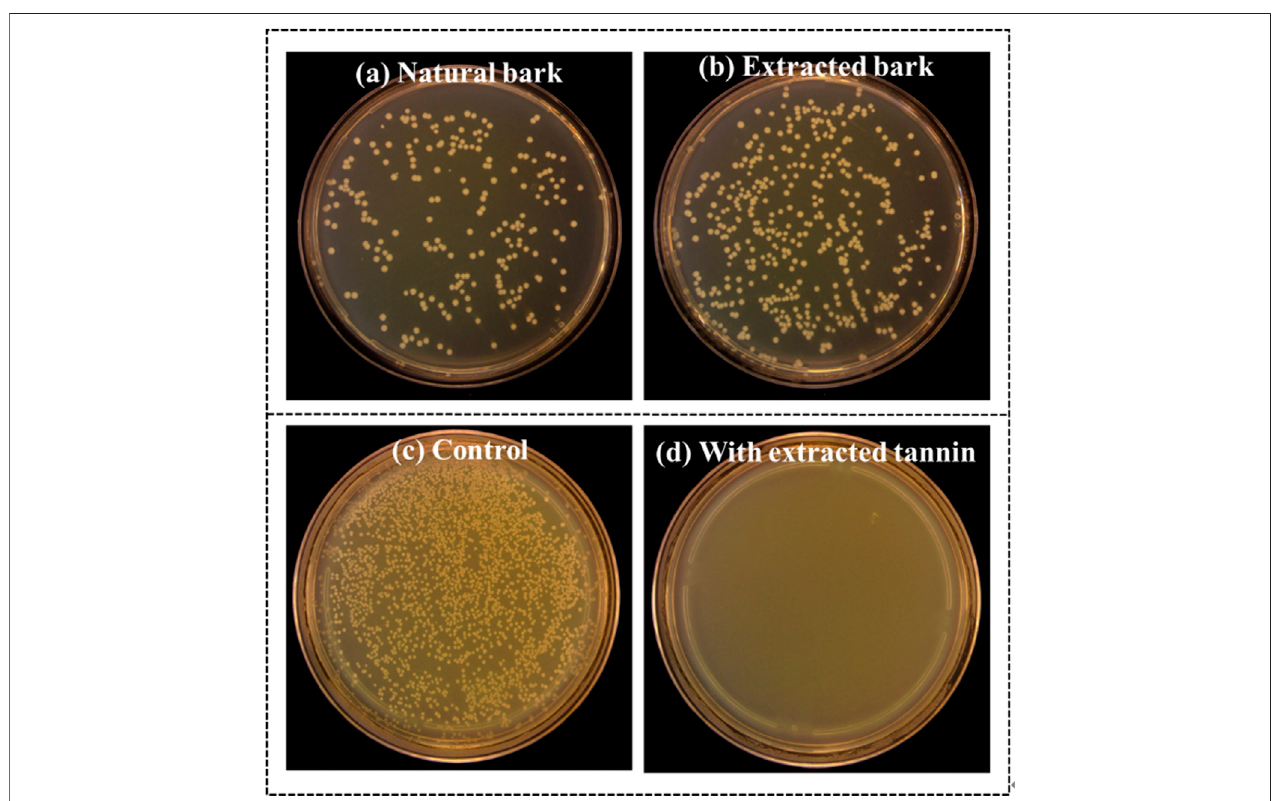
FIGURE 4 | Bacteria colonies on the medium plates. (a) E. coli co-cultured with natural mangrove bark. (b) E. coli co-cultured with extracted mangrove bark. (c) Cultured E. coli . (d) E. coli co-cultured with extracted mangrove tannin.